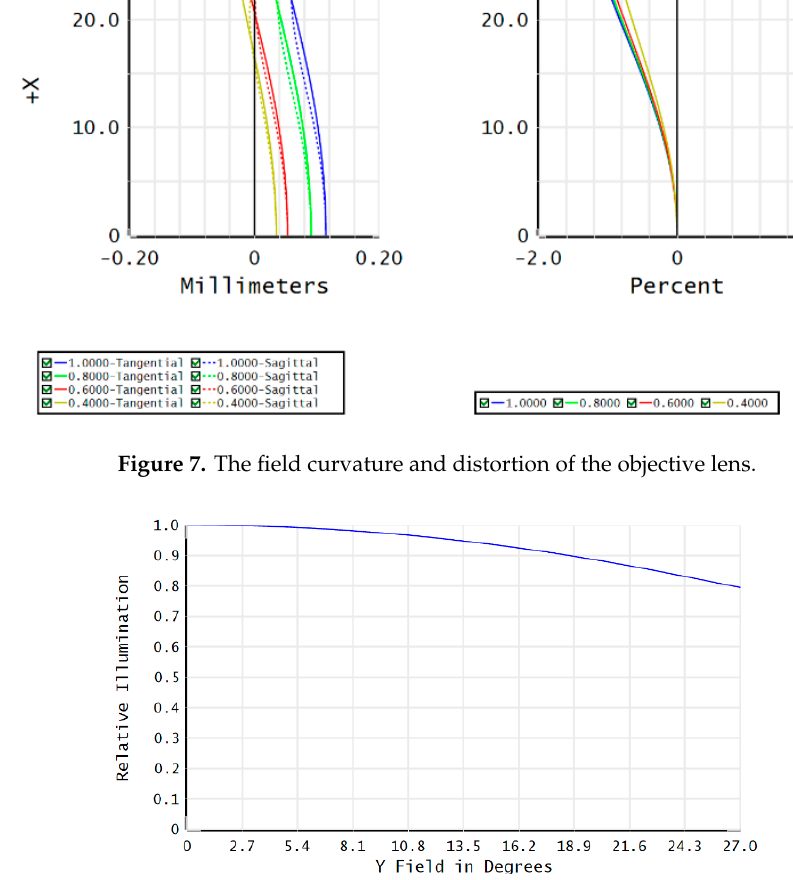
Figure 8. The relative illumination of the objective lens.